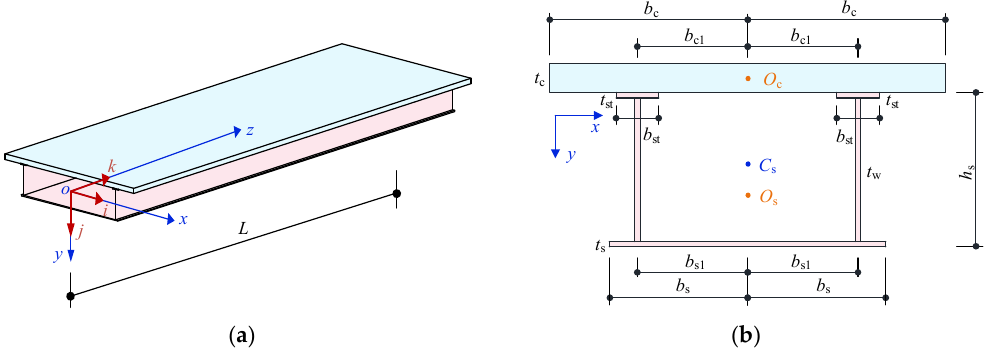
From the above assumptions and the coordinate system in Figure 2, the transverse displacement u ( x , y , z ) and vertical displacement v ( x , y , z ) at any point of the beam, dis- placement of the concrete slab w c ( x , y , z ), and displacement of the steel beam w s ( x , y , z ) in longitudinal direction are expressed as follows: